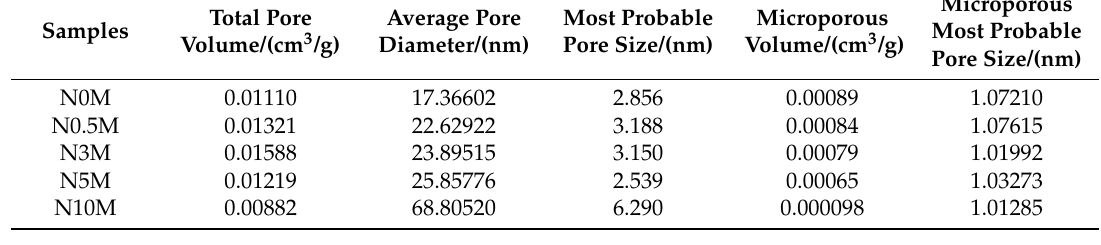
Table 2. The pore structure parameters of coal samples under different concentrations of nitric acid.